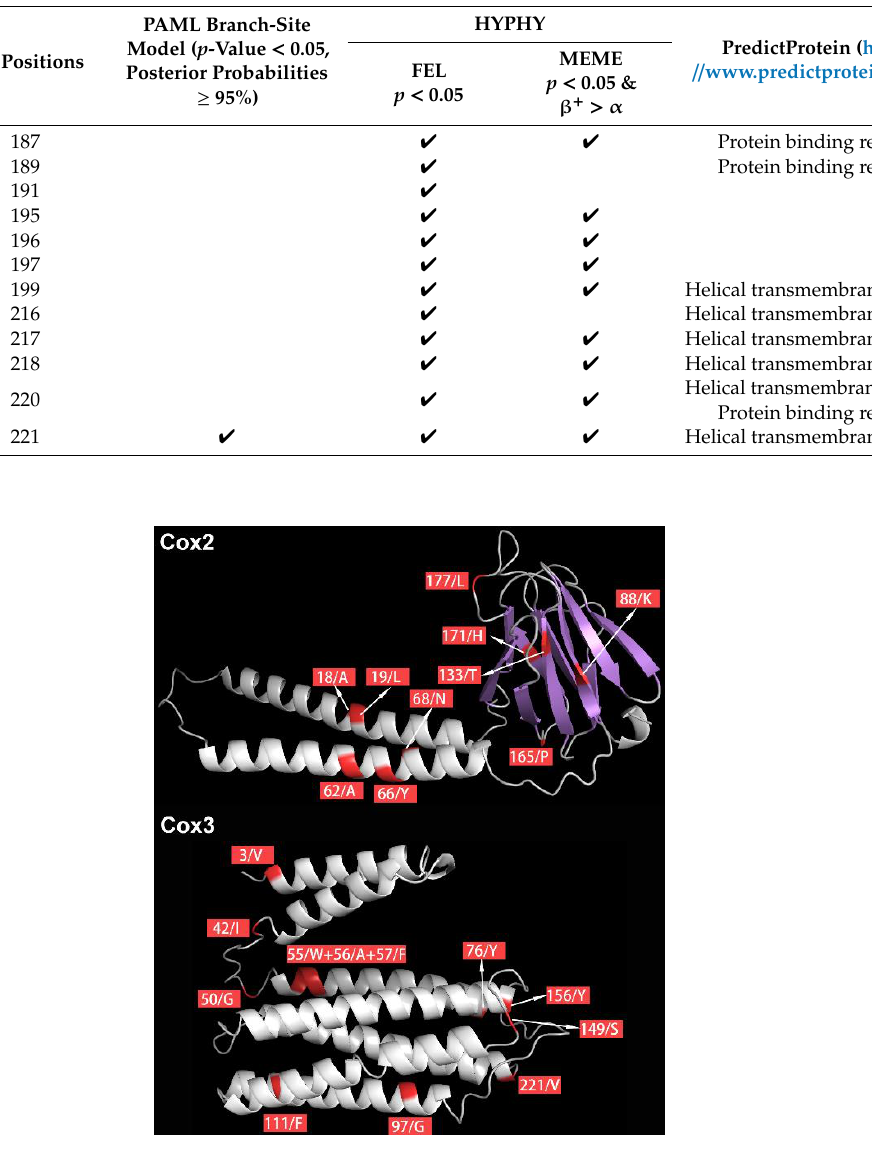
Figure 4. Distribution of positively selected sites in the three-dimensional (3D) structures of Cox2 and Cox3 proteins. The positively selected sites are shown in red. Table 2. Positively selected sites of cox2 and cox3 genes identified by PAML, and HYPHY.